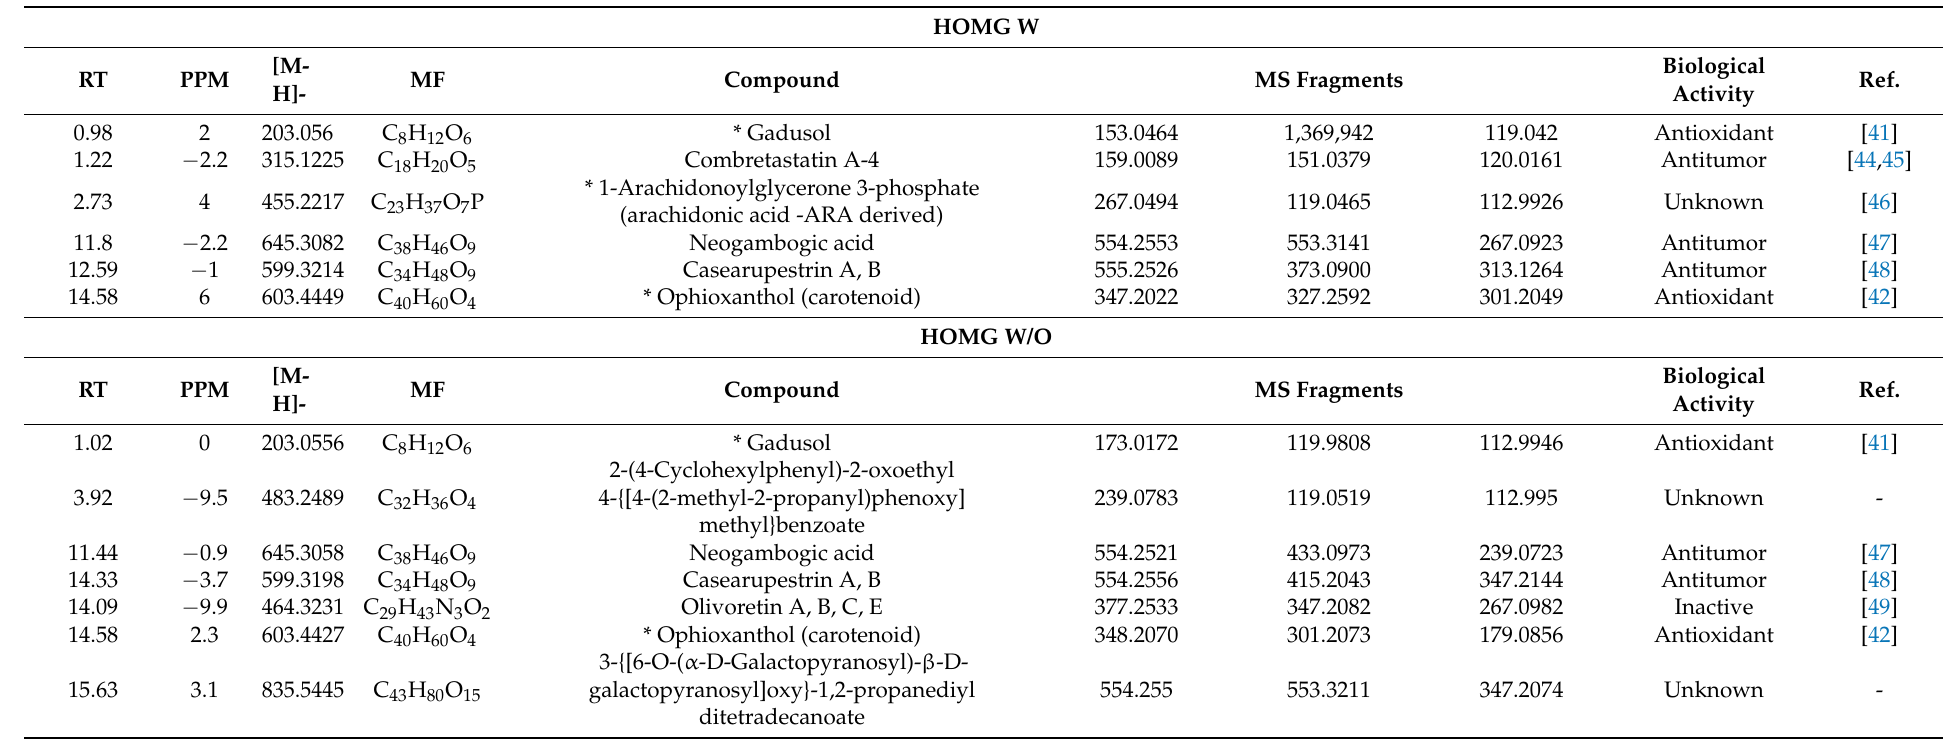
Table 1. Bioactive compounds (tentative identification) in the crude homogenates from Anemonia sulcata